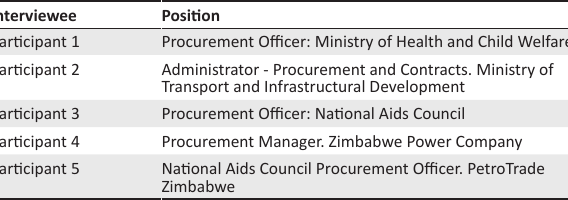
TABLE 1: List of participants.